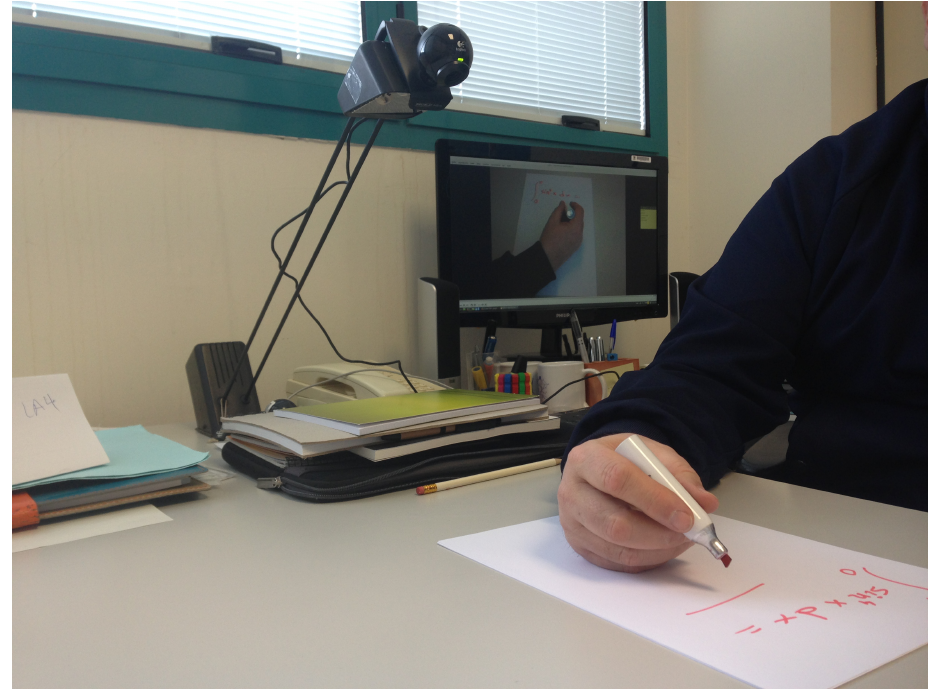
Figure 2. Communication based on a computer and